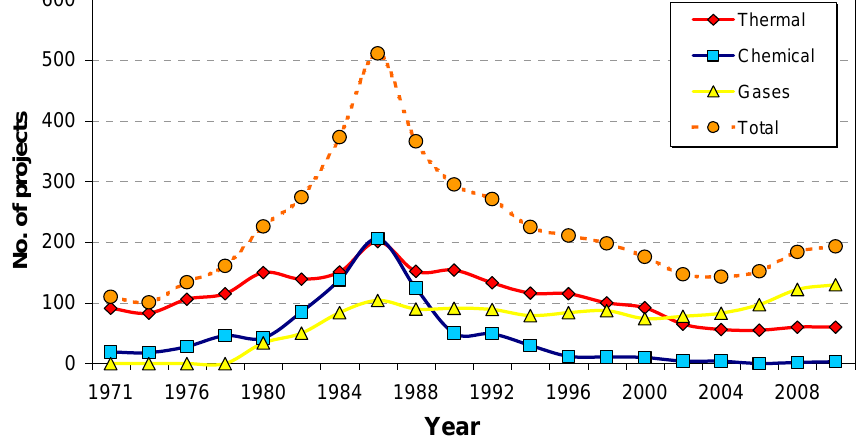
Figure 1. Evolution of EOR projects in the United States (From Oil & Gas Journal EOR Surveys